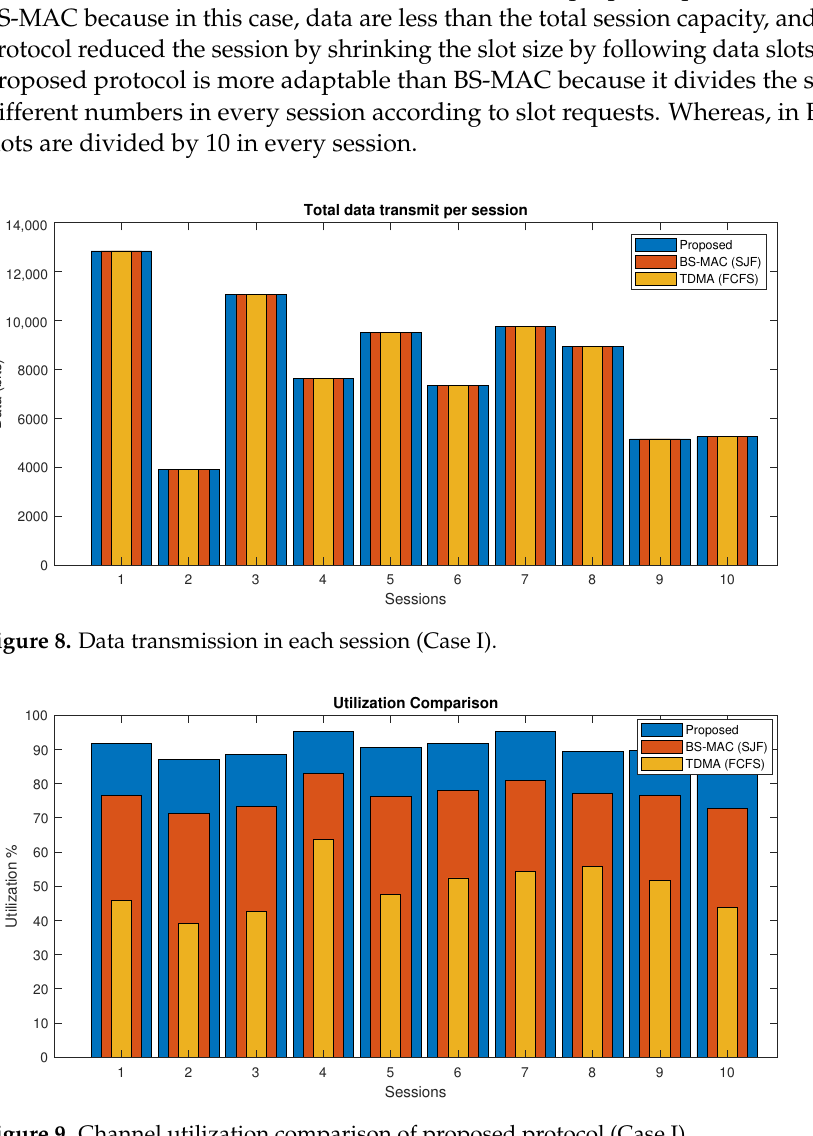
Figure 9. Channel utilization comparison of proposed protocol (Case